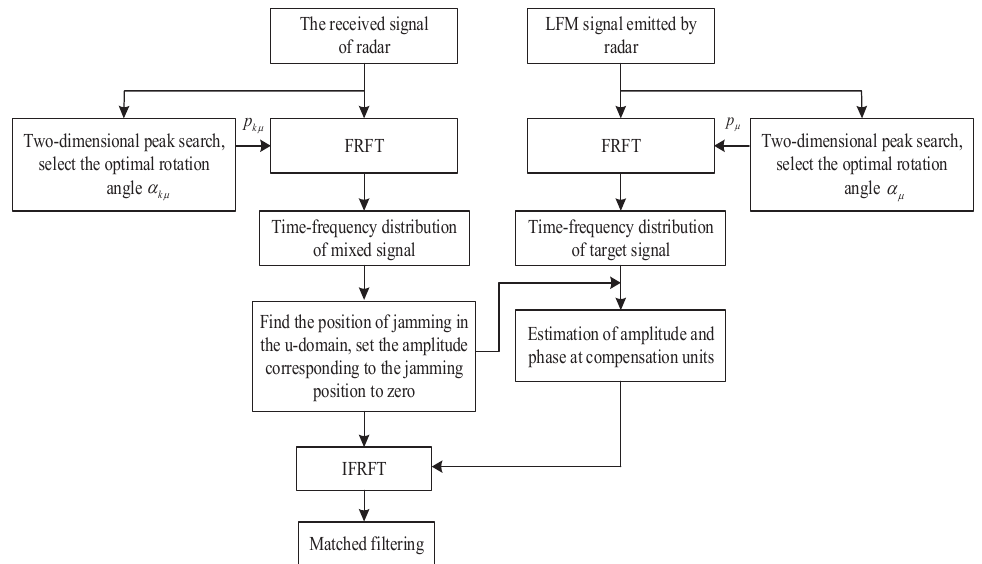
Figure 2. Flow diagram of the algorithm for SMSP jamming